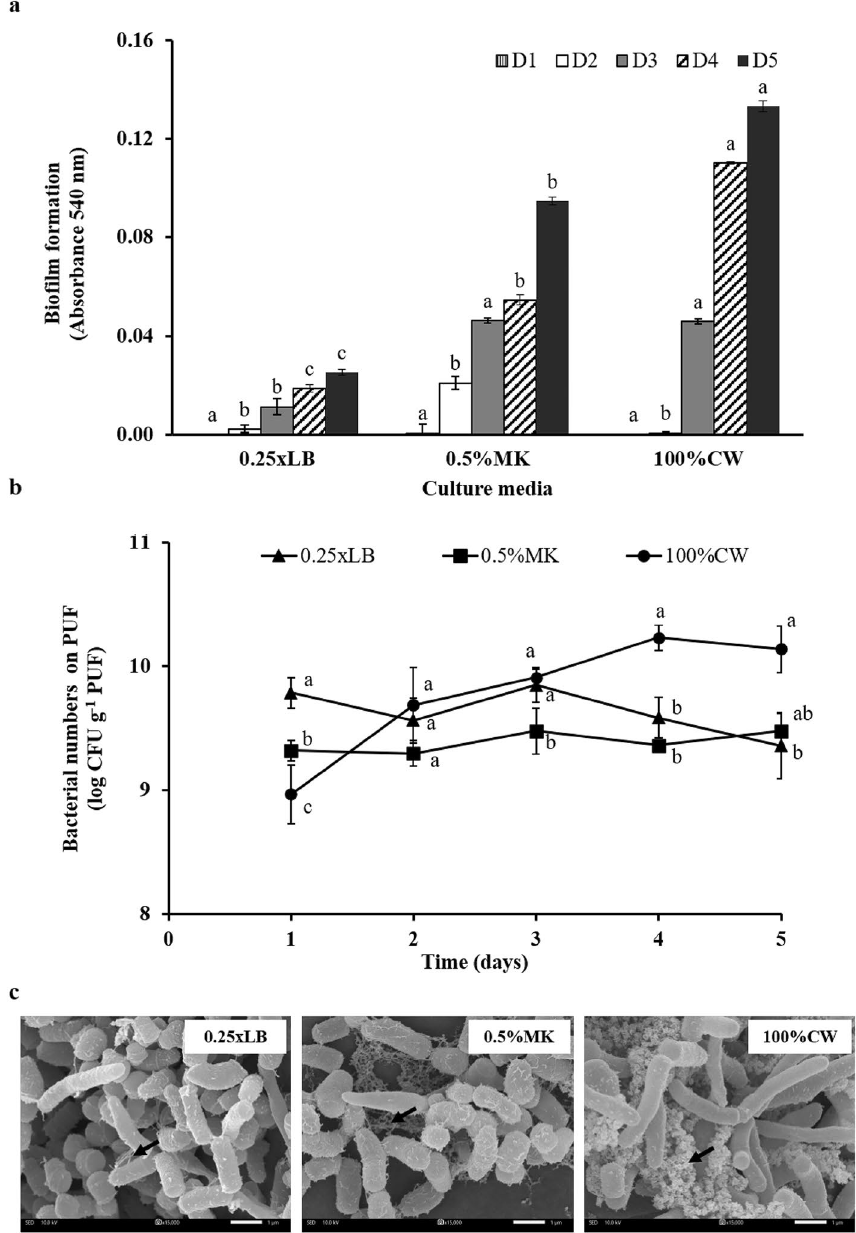
Figure 2. Biofilm formation of R. ruber S103 cultured in 0.25xLB, 0.5%MK and 100%CW and statically incubated at room temperature for 5 days ( a ). Bacterial numbers of S103 immobilized on PUF in different media at room temperature (30–33 °C) with shaking at 200 rpm for 5 days ( b ). The lowercase letters above the lines and vertical bars represent significant differences ( P < 0.05) in the culture medium on each day. SEM micrograph (15,000×) of immobilized cells grown in different media for 1 day. Black arrows indicate biofilm secretion ( c